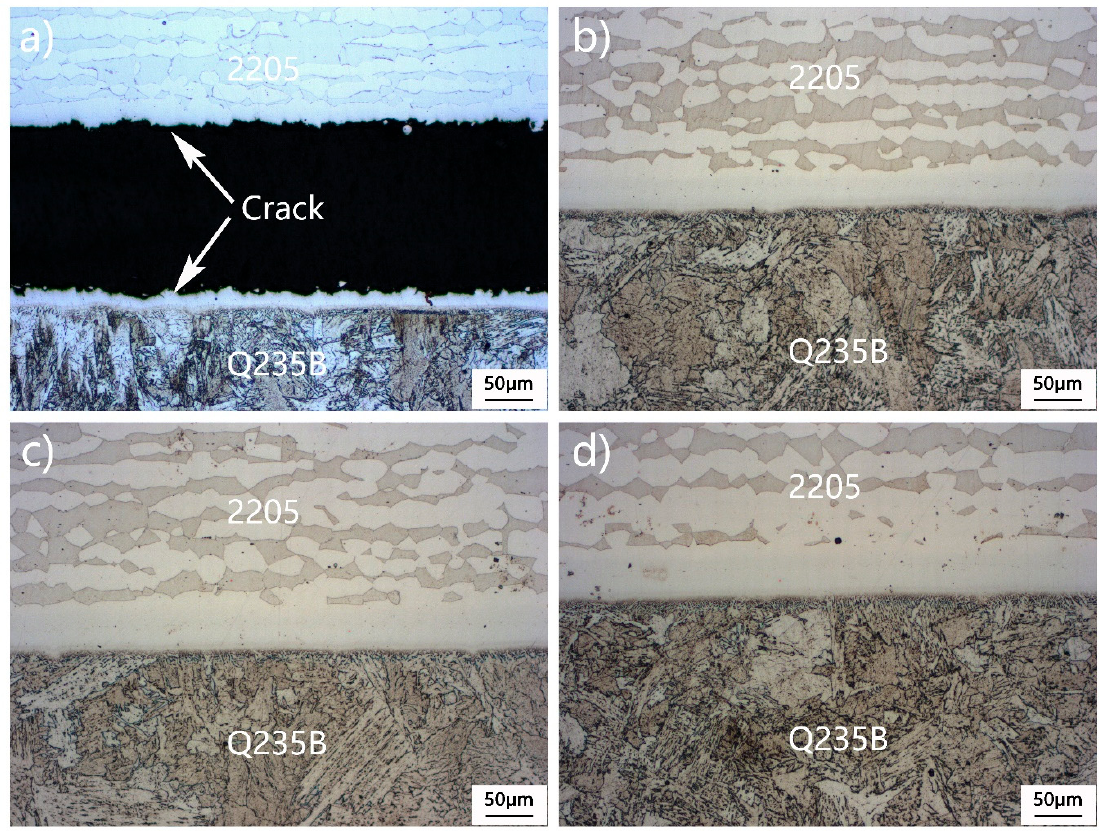
Figure 3. Microstructure of the cross section of the 2205/Q235B composite plate after different insulation times: ( a ) 1 h, ( b ) 2 h, ( c ) 3 h, and ( d ) 4 h.